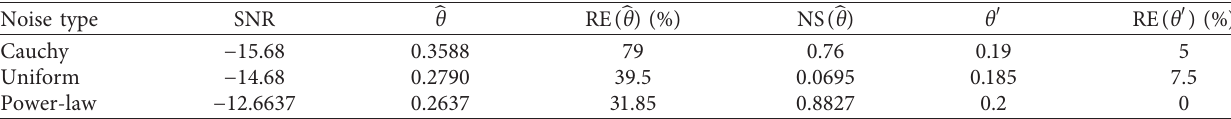
All the results are obtained via the average of 200 generated